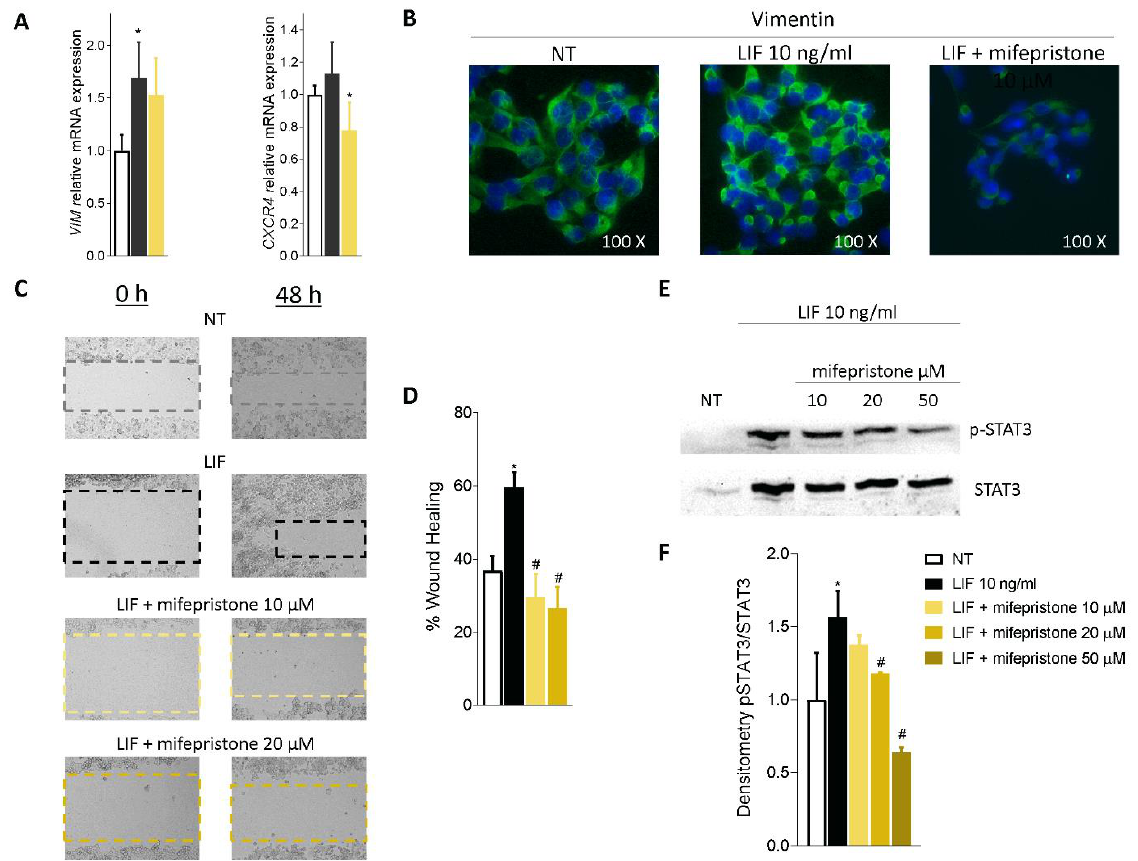
Figure 7. Mifepristone inhibits in vitro migration in STAT3-dependent signalling. ( A ) Relative mRNA expression of Vimentin and CXCR4. ( B ) Immunofluorescence analysis of Vimentin expression. ( C ) Scratch wound healing assay. MIA PaCa-2 cell monolayers were scraped in a straight line using a p200 pipette tip; then, they were left untreated or primed with LIF 10 ng/mL alone or in combination with mifepristone 10 or 20 µ M and EC359 25 nM. The wound generated was captured at 0 and 48 h of incubation with the compounds above described. The images show cell migration at the two times point indicated. ( D ) Images of obtained points were analysed, measuring scraped area and its closure vs. the first time point at 0 h. Results are the mean ± SEM of three samples per group (* represents statistical significance versus NT, and # versus LIF, p < 0.05). ( E ) Analysis of STAT3 signalling pathway. Representative Western blot analysis of STAT3 and phospho-STAT3, proteins in MIA-PaCa-2 cells exposed to LIF (10 nM) alone or in combination with increasing concentration of mifepristone (10, 20, 50 µ M) for 20 min. ( F ) Densitometric analysis demonstrating phospho-STAT3/STAT3